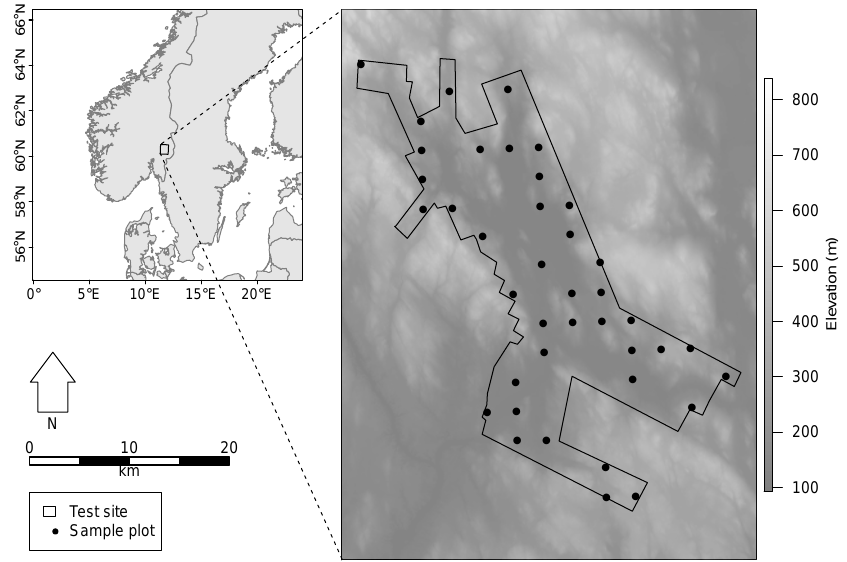
Figure 1. Overview of the study area with a standard Norwegian DTM in the background.